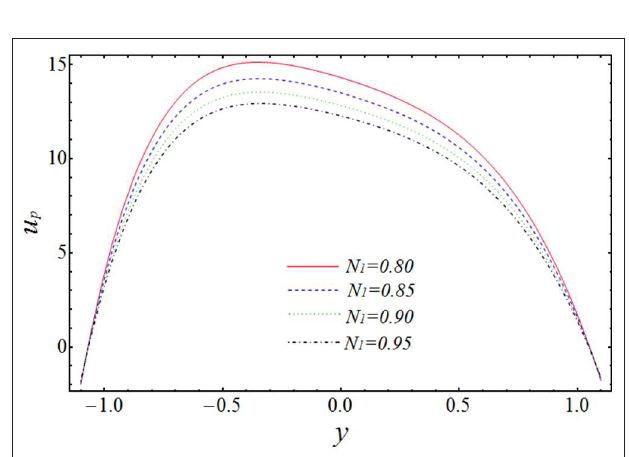
FIGURE 5 | Change of velocity u p for N 1 when Q = 1, x = 1, φ = 0.1, k 1 = 9, B = 0.02, A = 0.1, C =